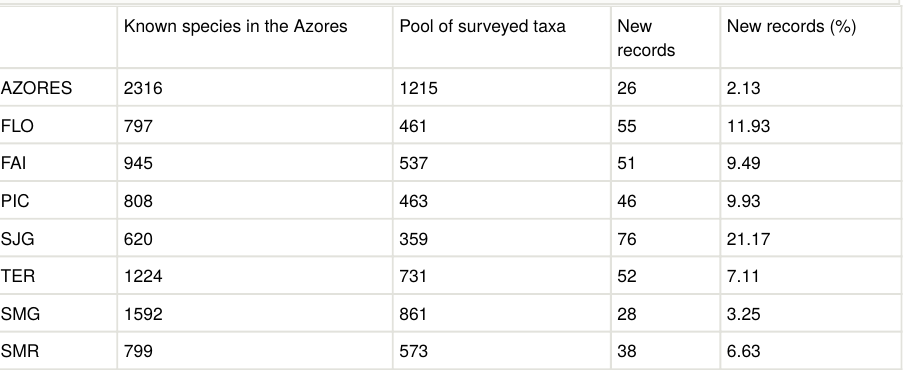
Species richness for the Azores archipelago and each island. Total currently known species, the number of species surveyed during this study and those that represent new records are